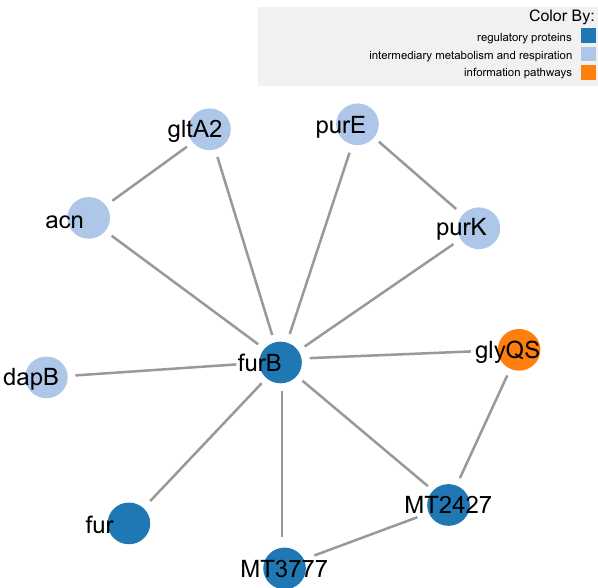
Figure 1. Mycobacterium tuberculosis proteins that interact with furB and the interactions between them (using force-directed layout).